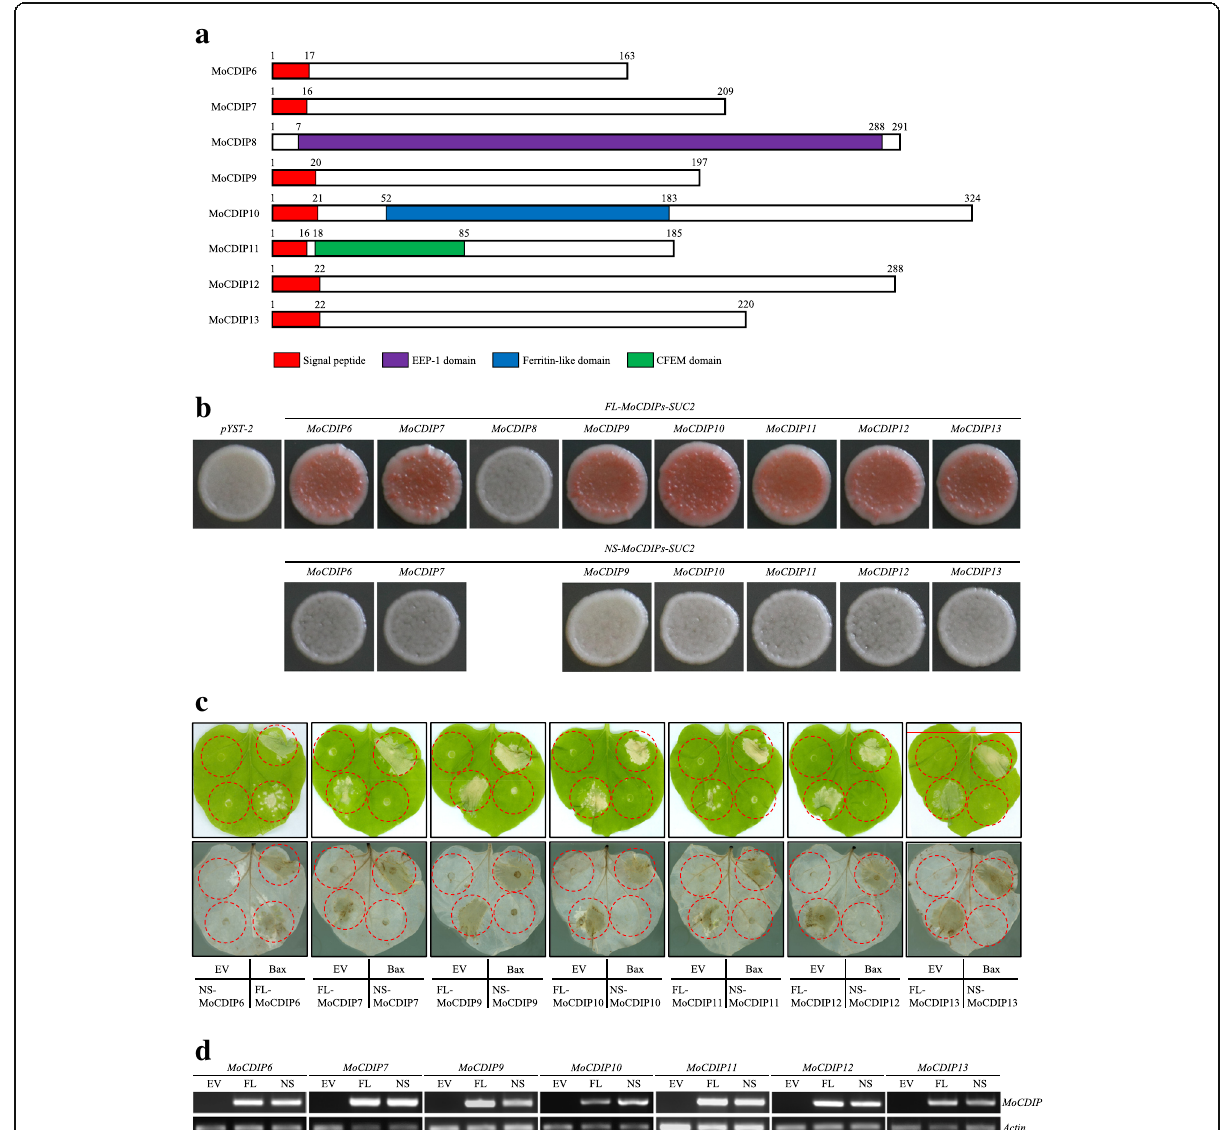
Fig. 3 Sequence analysis and functional validation revealed that the signal peptides of seven MoCDIPs were required for cell death-inducing activity in N. benthaminana . a Structural analysis of the eight MoCDIPs. b Functional validation of the predicted signal peptides of seven MoCDIPs based on a yeast secretion assay system. pYST-2 , yeast colony transformed with an empty vector containing a truncated yeast invertase Suc2 gene lacking its original signal peptide sequence. FL-MoCDIPs-Suc2 , yeast colonies transformed with full length MoCDIPs fused in frame with Suc2 . NS-MoCDIPs-Suc2 , truncated version lacking the predicted signal peptide sequence of MoCDIPs fused in-frame with Suc2 . Yeast colonies grown on SD/ − Leu medium were replica-plated onto sucrose selection medium for about 3 days. Strains unable to secrete invertase were inhibited on sucrose medium (white color), whereas strains able to secrete invertase could grow on sucrose medium (red color). c Transient expression of truncated non-signal peptide version of MoCDIPs did not cause cell death in N. benthamiana leaves. EV, an empty vector pGD. H 2 O 2 accumulations in N. benthamiana leaves were shown by DAB staining. d RT-PCR analysis of MoCDIPs mRNA expression in agroinfiltrated N. benthamiana leaves. Total RNAs were extracted from infiltrated leaf tissues at 36h post infiltration. EV, RT-PCR results from leaf tissues infiltrated with the empty vector pGD. FL, RT-PCR results from leaf tissues infiltrated with FL-MoCDIPs . NS, RT-PCR results from leaf tissues infiltrated with